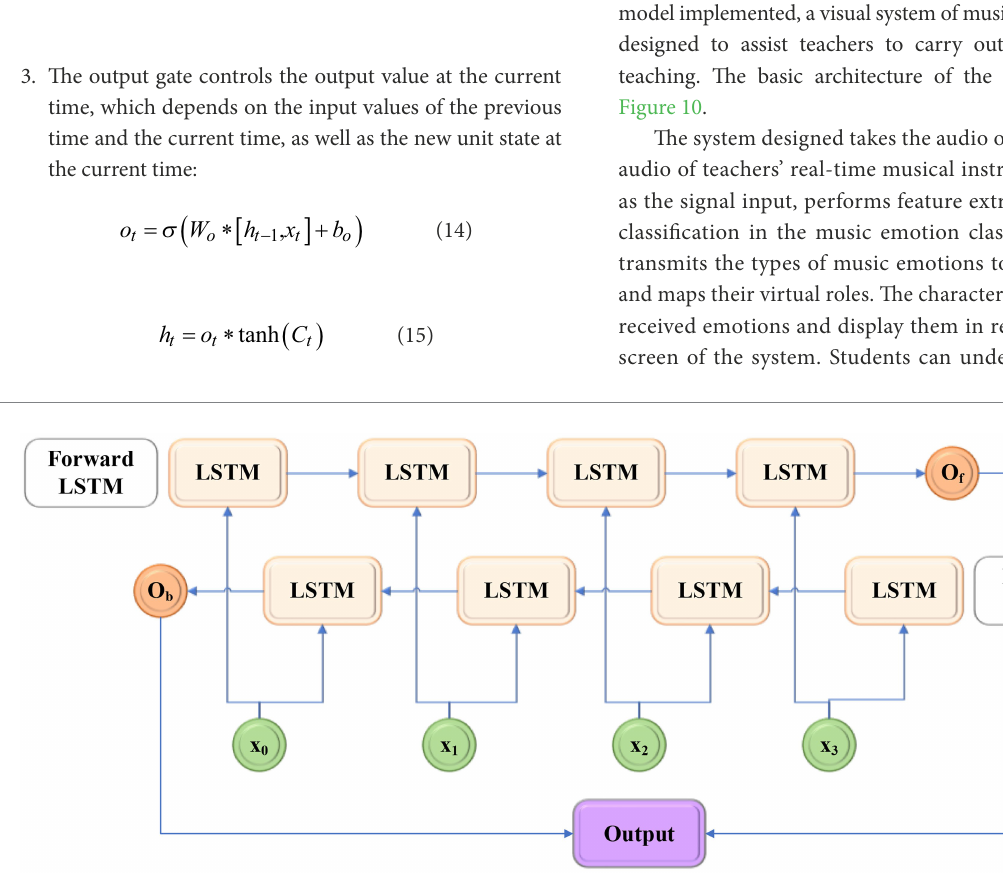
FIGURE 9 Structure of bi-directional long short-term memory (Bi